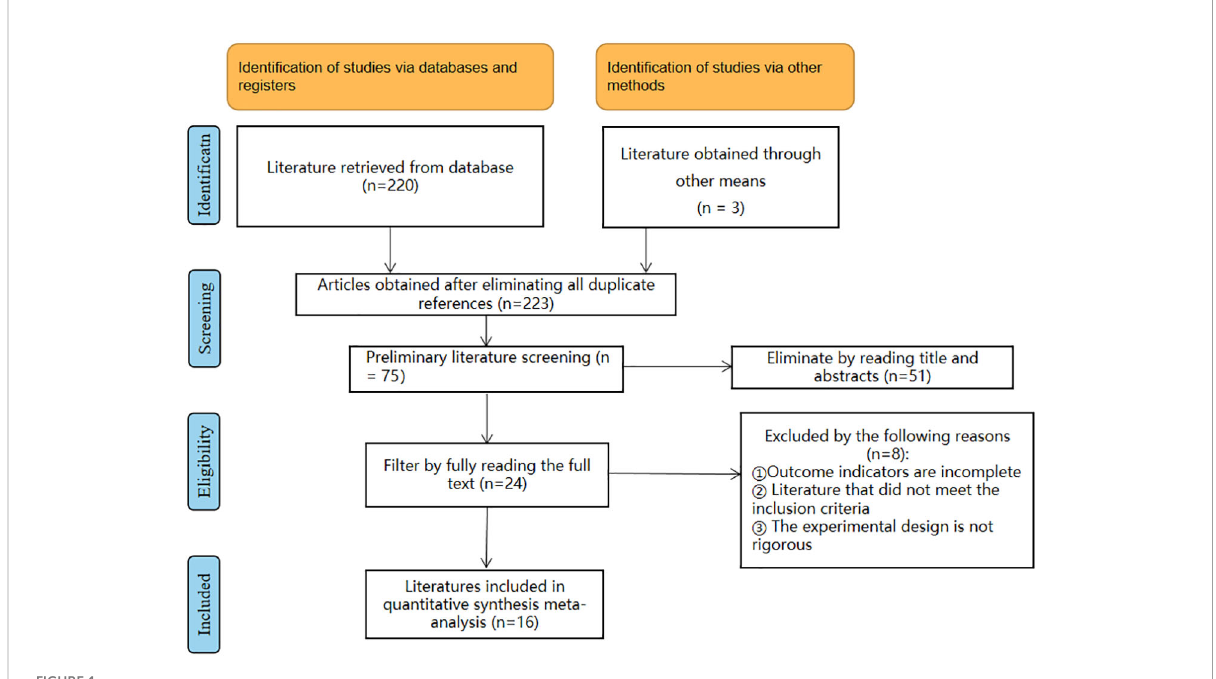
FIGURE 1 Flow diagram of literature